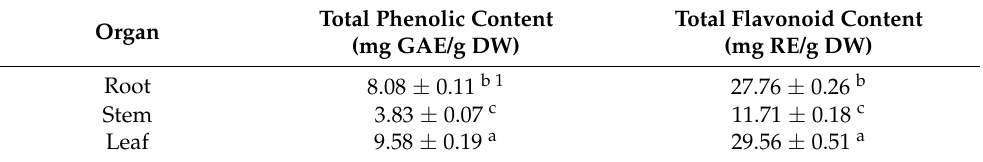
Table 2. Total phenolic and total flavonoid content in the roots, stems, and leaves of Lavan- dula pubescens